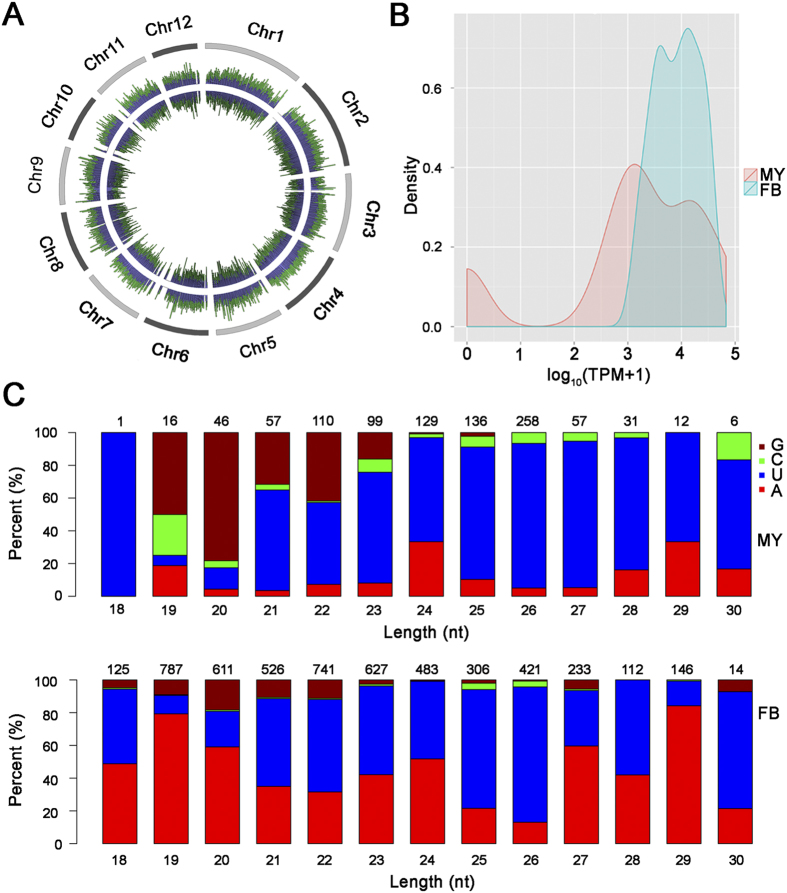
Characterization of small RNAs in G. sinense.A) Distribution of small RNAs mapping to G. sinense chromosomes. From outside to inside, grey lines represent chromosomes. Line graph represents forward and reverse mapped small RNAs. Green and purple lines represent the density of small RNAs in mycelia and fruiting bodies, respectively. B) Distribution of small RNA TPM (transcripts per million clean reads) values in G. sinense mycelia (MY) and fruiting bodies (FB). C) Nucleotide bias at the 5’-terminus of small RNAs in G. sinense mycelia (MY) and fruiting bodies (FB).